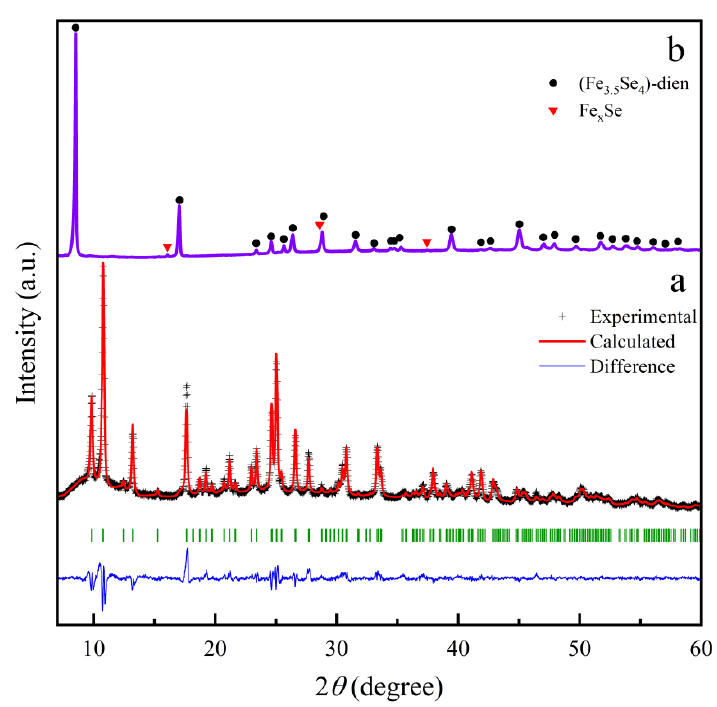
Figure 7. Powder XRD patterns of ( a ) [FeSe 2 ] 2 [Fe(dien) 2 ] particles and ( b ) (Fe 3.5 Se 4 )-dien plates. Given the redox reaction system at a higher temperature (503 K), Fe 3+ ions are prefer- ably reduced to Fe 2+ ions. When the molar ratio of Fe and Se atoms in the starting ma- terials changes from 3:4 to 3.25:4, a diffusion of more iron atoms into the orthorhombic [FeSe 2 ] 2 [Fe(dien) 2 ] would occur following the reaction formula (4), resulting in the mon- oclinic hybrid rods (Figure 4). A reasonable molecular formula for the hybrid rods is proposed as [Fe 3 + Fe 2 + Se 2 − ] 2 [Fe 2 + (dien) 2 ] 0.875 according to electrical neutrality princi- 0.875 3 1.125 ples. The content of 0.875 dien/cell is obtained by balancing chemical Equation (4), which is almost the same as the experimental value of 0.9 dien/cell for the present hybrid rods determined above. Assuming that the small difference between the calculated and the experimental values is in range of the analytical error, we propose that the monoclinic hybrid rods are built by Fe 2 Se 3 double chains and Fe(dien) 2 complexes in the model (II). Moreover, further increases in the molar ratio of Fe and Se to 3.5:4 and the reaction temperature to 513 K result in the hybrid nanoplates. Figure 8 shows the morphology transformation from particles for the orthorhombic phase to rods for the monoclinic phase and plates for the (Fe 3.5 Se 4 )-dien. Figure 7b presents the XRD pattern of (Fe 3.5 Se 4 )-dien hybrid plates. Two strong peaks at low 2 θ angles of 8.48 ◦ and 17.00 ◦ with lattice spacings